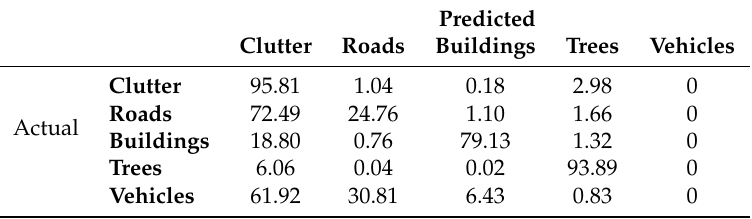
Table A13. Normalized confusion matrix for the decision tree model that is trained on hand-crafted coordinates features and